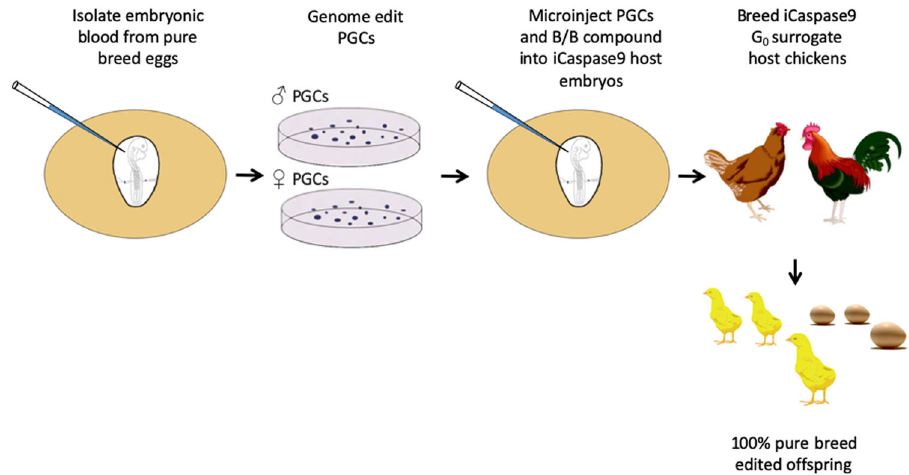
Fig. 3 Schematic of SDS mating. PGCs are isolated and propagated in vitro from a pure chicken breed. After genome editing and clonal isolation, the male and female PGCs are mixed with the B/B compound and injected into iCaspase9 surrogate host embryos. The embryos are hatched, raised to sexual maturity then mated. Laid eggs and hatched offspring are from the donor breed of interest and contain the desired genome edit. Drawing by MJM. Table 1 Germline transmission rates from surrogate hosts injected with donor PMEL17 edited WL PGCs. iCaspase9 host No. of eggs No. of eggs mating groups laid per week * incubated